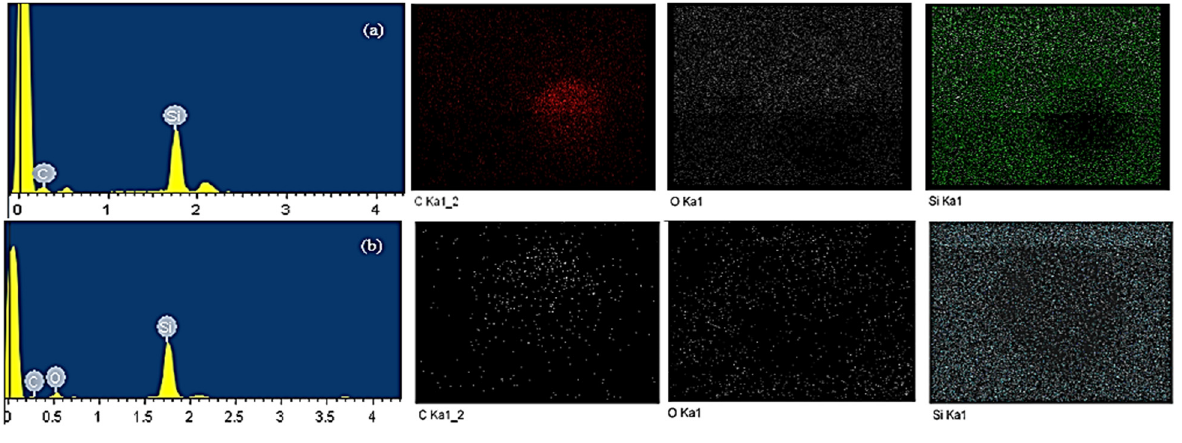
Figure 9. SEM image of ( a ) ×600 and ( b ) ×2k of PDMS/PU (95:5) with 3 wt.% SiO 2 composites. Table 2. EDX analysis results including weight and atomic percentage of various elements found on the surface of the materials.